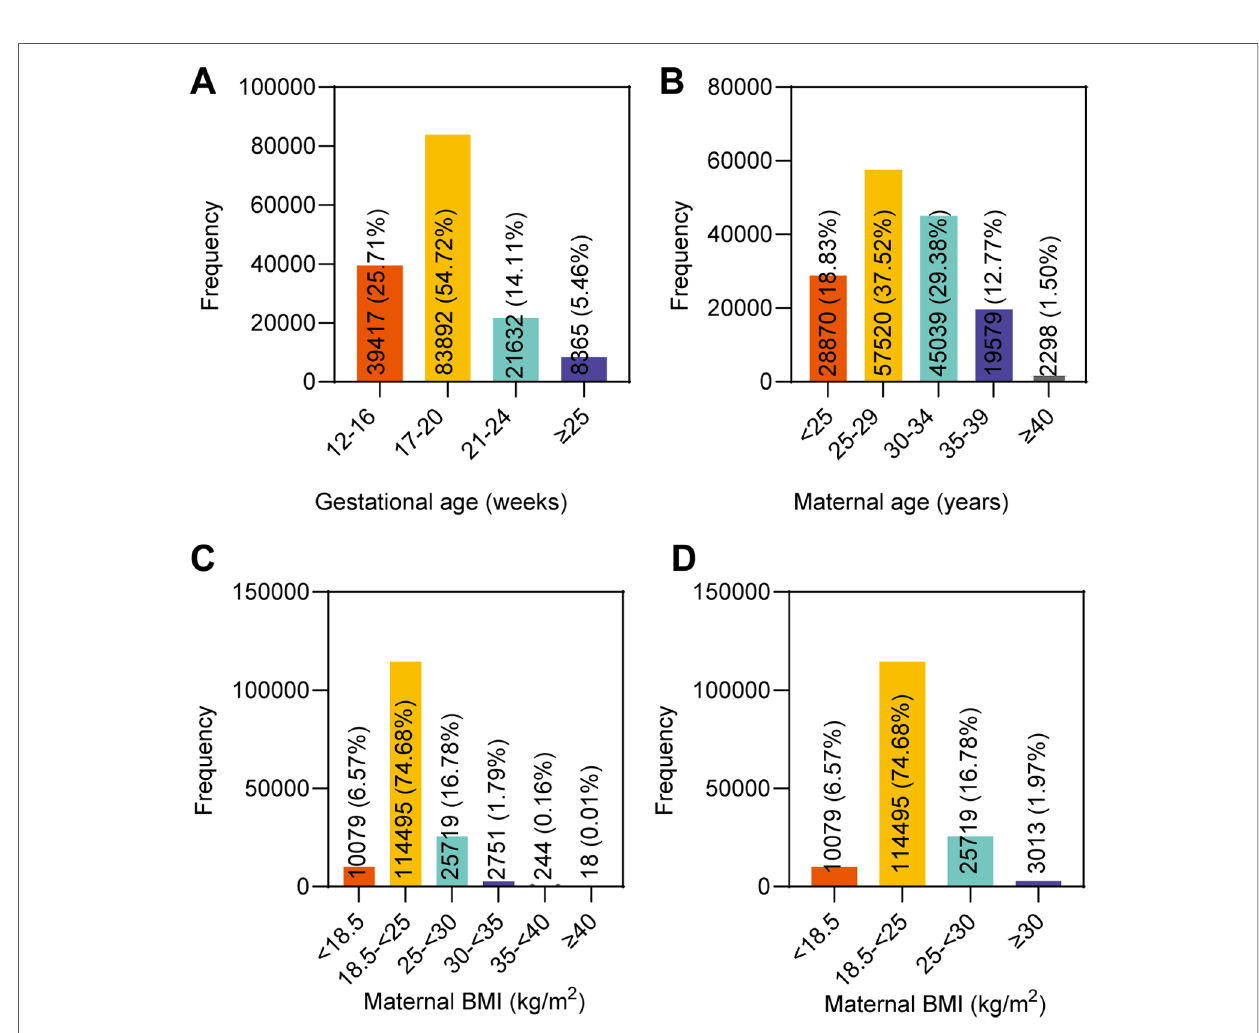
FIGURE 1 Distribution of maternal and fetal characteristics of the 153,306 singleton pregnant women in the study. ( A ) Gestational age. ( B ) Maternal age. ( C ) Maternal BMI in six groups. ( D ) Maternal BMI in four